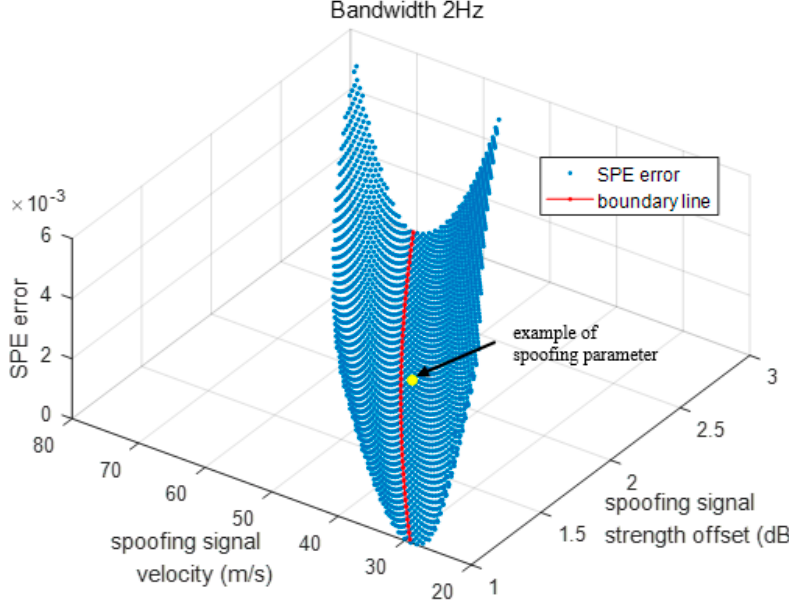
Figure 15. SPE error with respect to the spoofing signal strength and velocity in three dimensions.